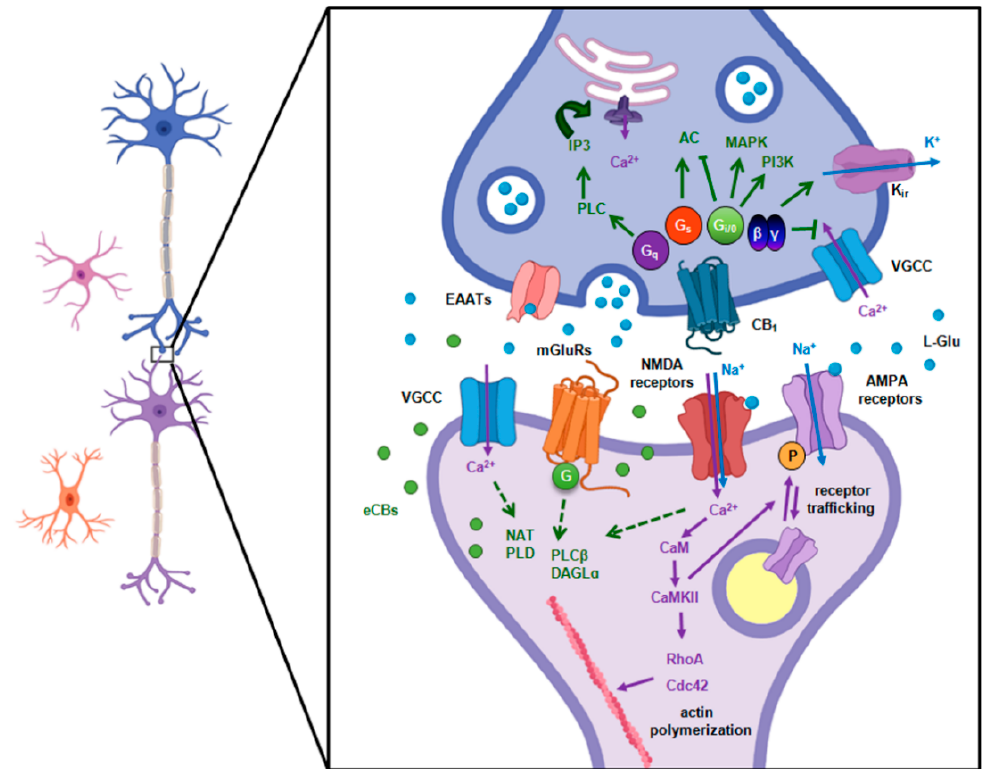
Figure 5. The stimuli involved in the establishment of synaptic plasticity and retrograde eCB signaling in the glutamatergic synapse. Glutamate release from the presynaptic terminal activates ionotropic (NMDA, AMPA, and kainate) and metabotropic glutamate receptors (mGluRs), that together with the Ca 2+ influx through VGCC are potent triggers for eCB production (indicated in green). Ca 2+ influx trough NMDA receptors is involved in the regulation of AMPA receptor trafficking, spine enlargement, and plastic changes in the strength of the synaptic transmission (indicated in purple). AC, adenylate cyclase; AMPA, α -amino-3-hydroxy-5-methyl-4-isoxazolepropionic acid receptor; CaM, calmodulin; CaMKII, calcium-calmodulin dependent protein kinase II; Cdc42, cell division control protein 42 homolog; DAGL, diacylglycerol lipase; EAATs, e xcitatory amino acid transporters; eCBs, endocannabinoids; Glu, glutamic acid; IP3, inositol 3-phosphate; K ir , inward-rectifier potassium channel; MAPK, mitogen-activated protein kinase; mGluRs, metabotropic glutamate receptors; NAT, N-acyltransferase; NMDA, N-methyl-D-aspartate receptor; PI3K, phosphatidylinositol 3-kinase; PL, phospholipase; RhoA, Ras homolog family member A; VGCC, voltage-gated calcium channels .